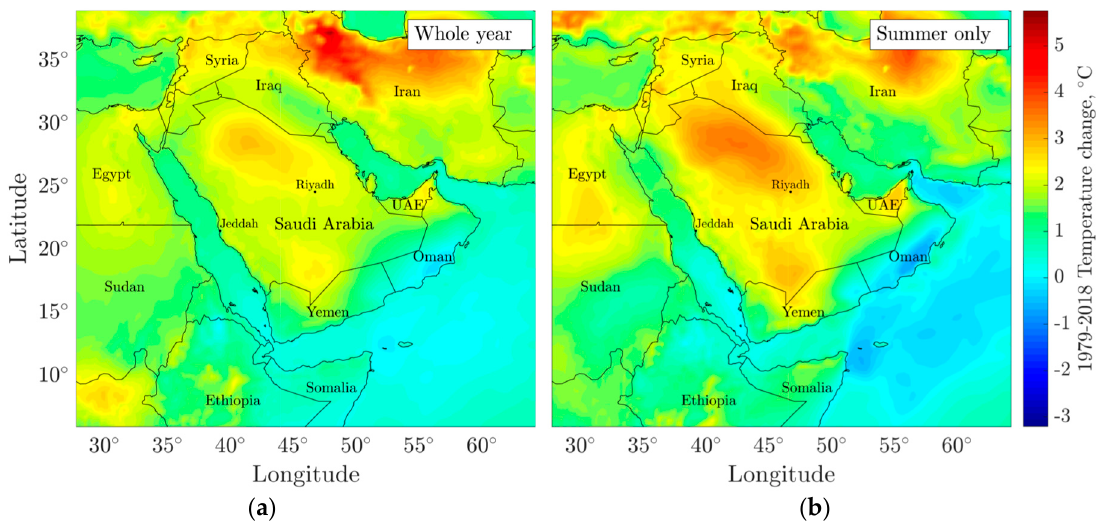
Figure 8. Temperature change from 1979 to 2018. ( a ) whole year ( b ) summer only. Authors based on ECMWF ERA5 Dataset.